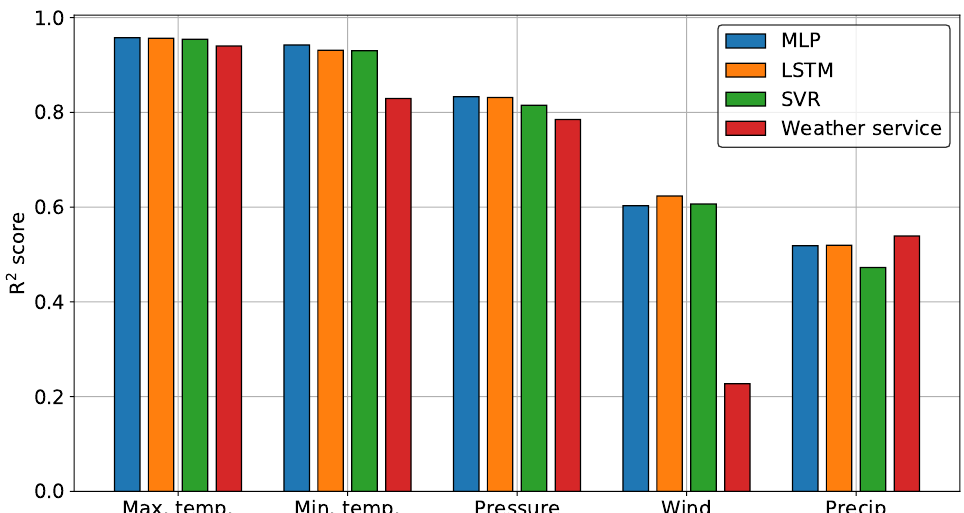
Figure 8. Comparison of the values of the R 2 score for all predicted parameters obtained by the MLP and weather